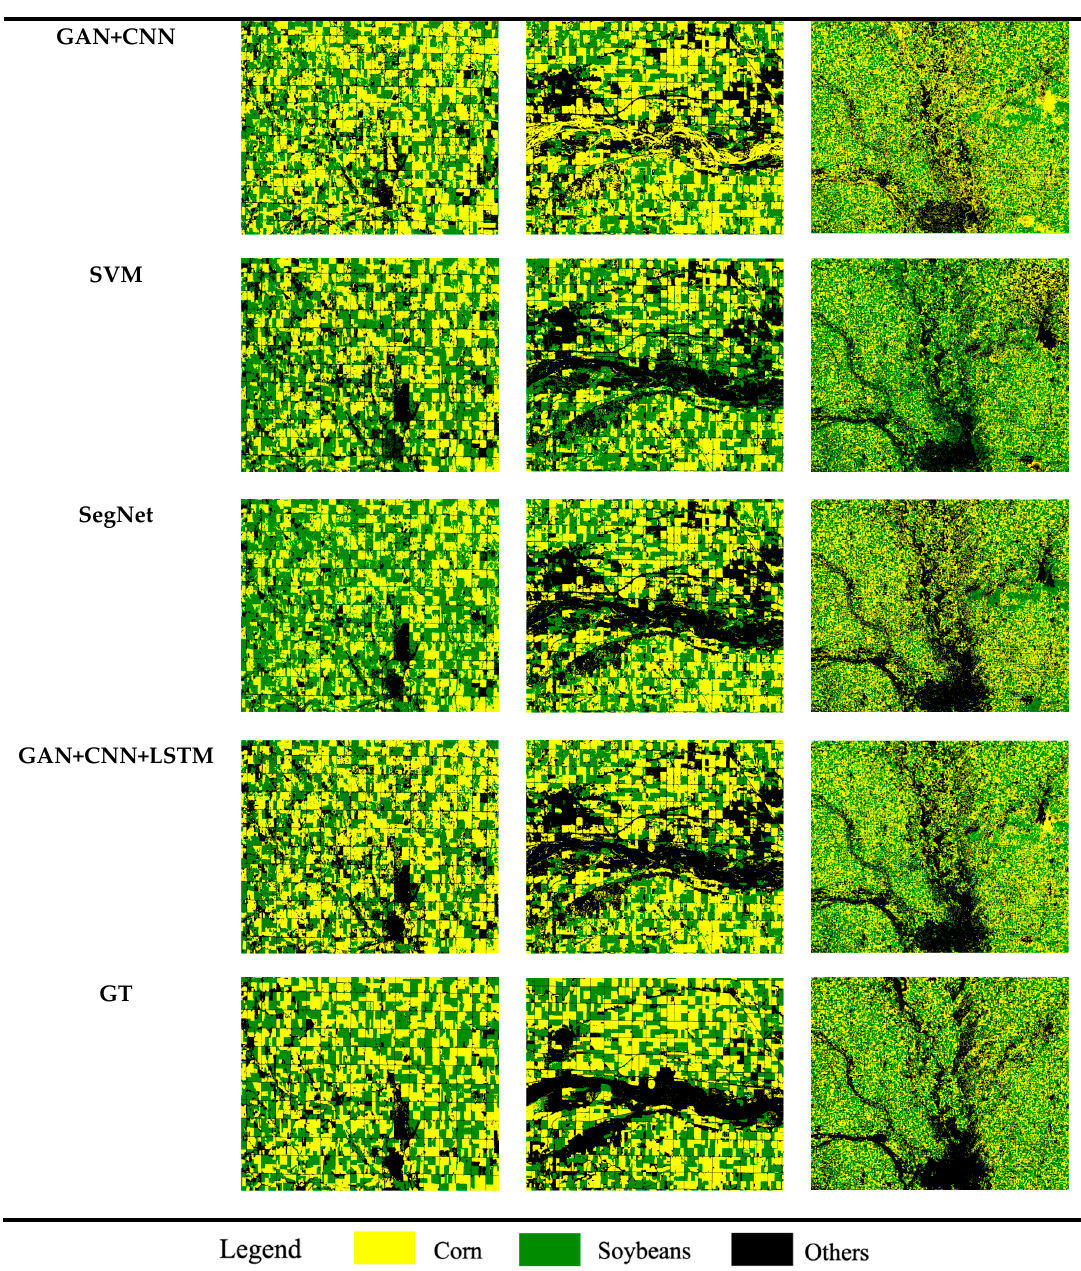
Figure 8. Visualization of the results of the model trained in the second experiment on the original image.